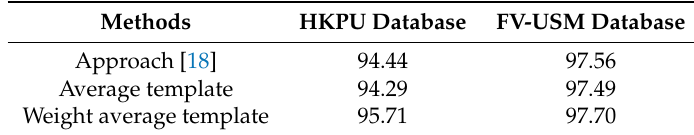
Table 2. Identification accuracy of various approaches on both